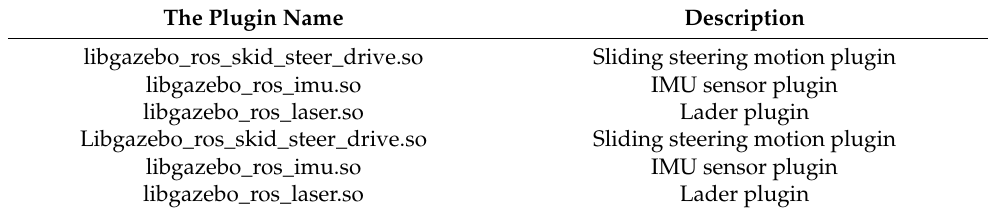
Table 3. Plugin description in Gazebo.